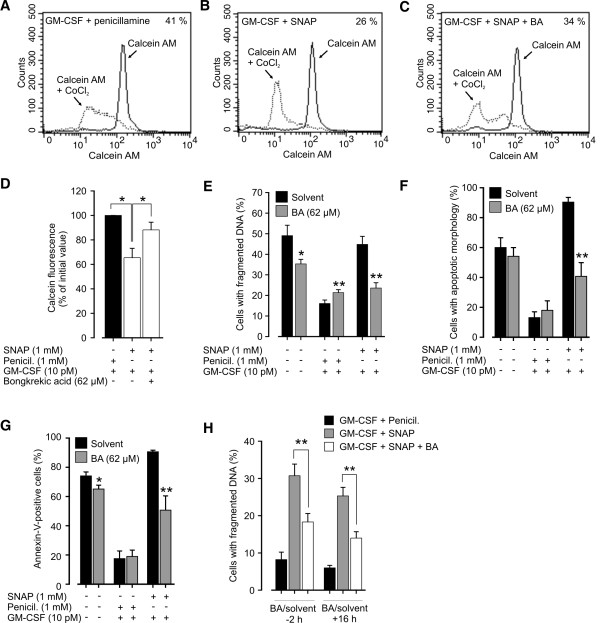
SNAP-induced apoptosis is dependent on late mPT but preceded by early partial mPT. Bongkrekic acid (62 μM) or solvent was added either 2 h before (A-H) or 16 h (H) after 10 pM GM-CSF, 1 mM SNAP and/or 1 mM penicillamine. In A-D Eosinophils were incubated for 1 h after which mPT was determined by calcein AM/CoCl2-method as described in materials and methods. In A-C shown are representative graphs from analysis of mPT and in the top right corner percentage of calcein fluorescence of its initial value describing the extent of mPT. In E-H total incubation time of eosinophils was 40 h after which apoptosis was determined by DNA fragmentation assay (E, H), morphological analysis (F) or Annexin-V FITC staining (G). Values are mean ± SEM from five to six independent experiments, * indicates p < 0.05 and ** p < 0.01 as compared with the respective control.